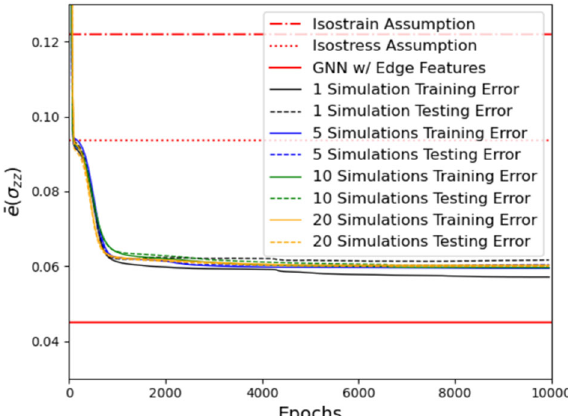
Fig. 7 Effects of removal of edge features in GNN model prediction accuracy. Learning rates of LSHR grain-scale elastic response using various numbers of CEFEM simulations for training and testing without the inclusion of edge features and using the lattice orientation (components of the Rodrigues vector r ) as nodal